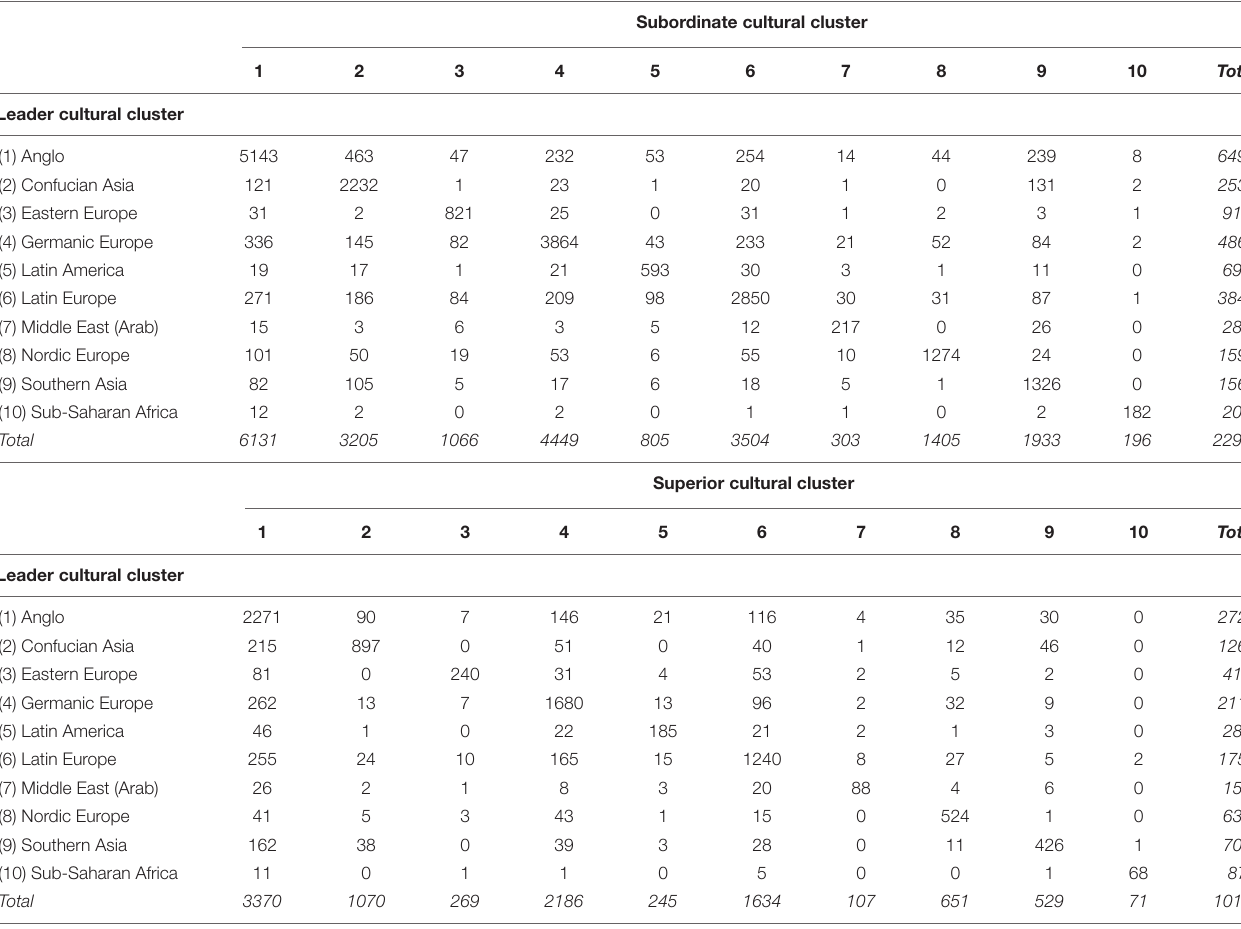
TABLE 1 | Leader–subordinate cultural cluster